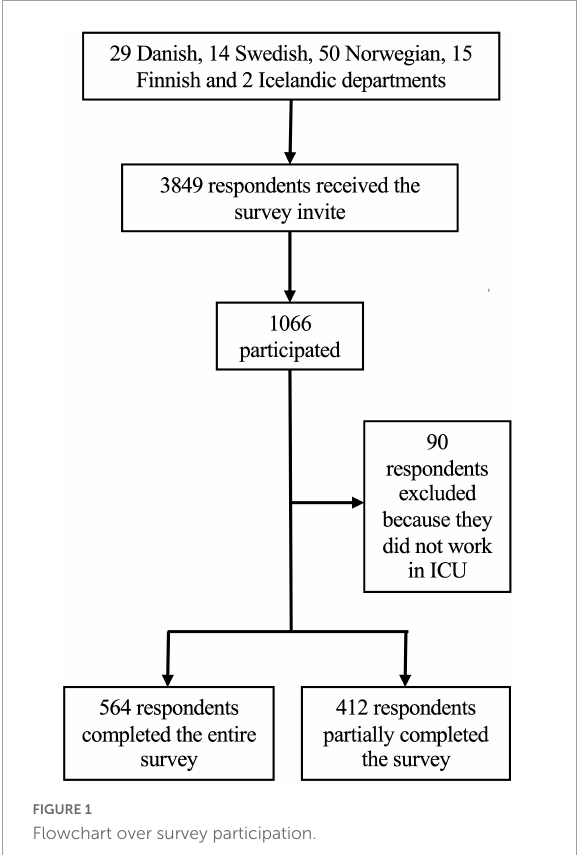
FIGURE1 Flowchart over survey